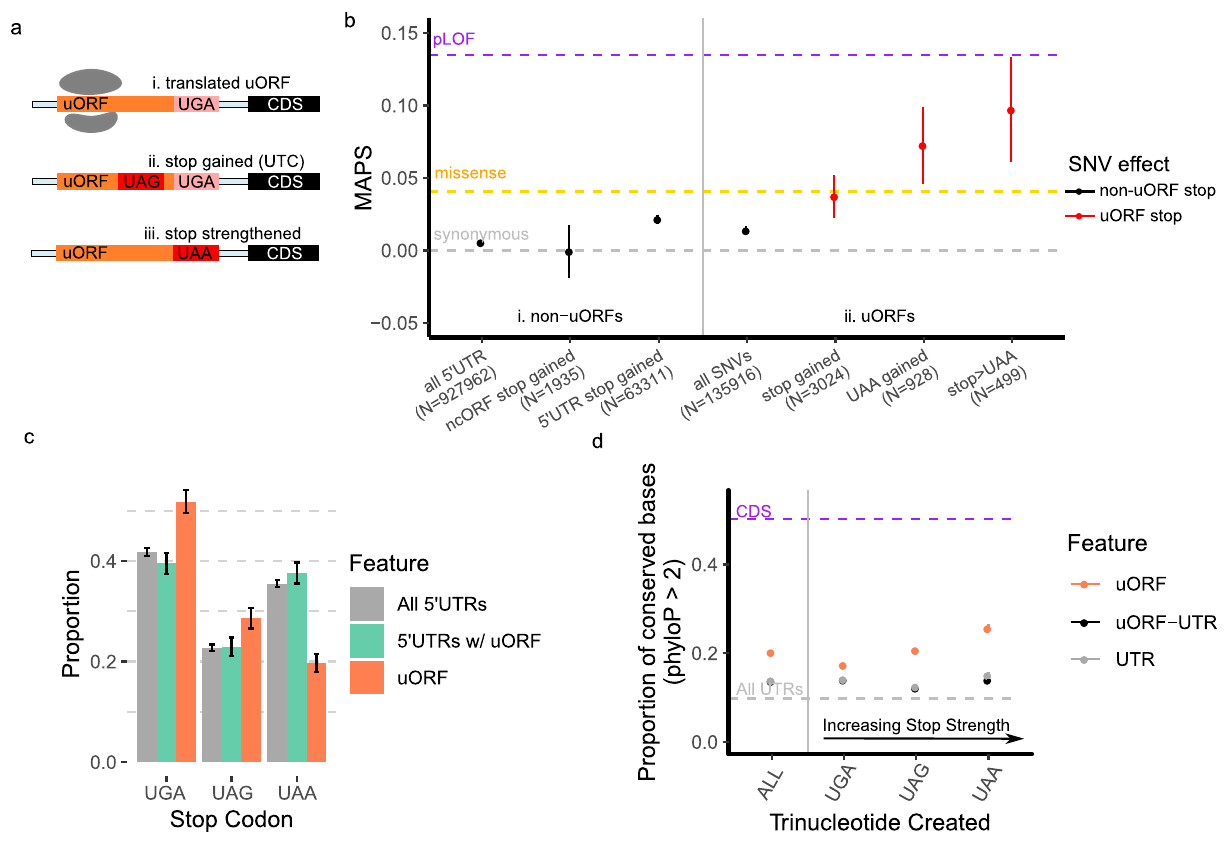
Fig. 1 Stop-introducing and stop-strengthening variants in translated uORFs are under strong negative selection. a Examples of possible stop-gained (UTC upstream termination codon) or stop-strengthened variants in translated uORFs. b Points showing mutability-adjusted proportion of singletons (MAPS) scores for different classes of stop-introducing variants in translated uORFs. Gray, orange, and purple dashed lines represent MAPS scores for synonymous, missense, and predicted loss-of-function (pLOF) SNVs affecting canonical protein-coding sequences in gnomAD. (i) MAPS scores for non- uORF variants including all 5 ′ UTR SNVs, stop gained variants in ncORFs in 3 ′ UTRs, lncRNAs, and pseudogenes), and all 5 ′ UTR stop gained variants. (ii) MAPS scores for all uORF SNVs and stop gained variants in uORFs show that uORF UTC variants are signi fi cantly enriched for singletons. This is also observed for UAA-creating, and stop-strengthening SNVs in translated uORFs. Error bars represent bootstrapped 90% con fi dence intervals. c Relative frequencies of trinucleotides used as uORF stop codons compared to untranslated regions of uORF-containing 5 ′ UTRs, or all 5 ′ UTRs shows uORFs are signi fi cantly enriched for weaker (UGA, UAG) stop codons and depleted of the UAA stop codons compared to control sequences. Mean proportion over n = 10,000 random samples with replacement are represented by columns. Error bars represent 95% bootstrapped con fi dence intervals. d Points representing the proportion of strongly conserved (phyloP >2) bases by phyloP scores from 100-way vertebrate alignments for uORF stop-creating, non- uORF stop-creating in uORF-containing UTRs, and non-uORF stop-creating in all UTR genomic positions. Error bars represent 90% bootstrapped con fi